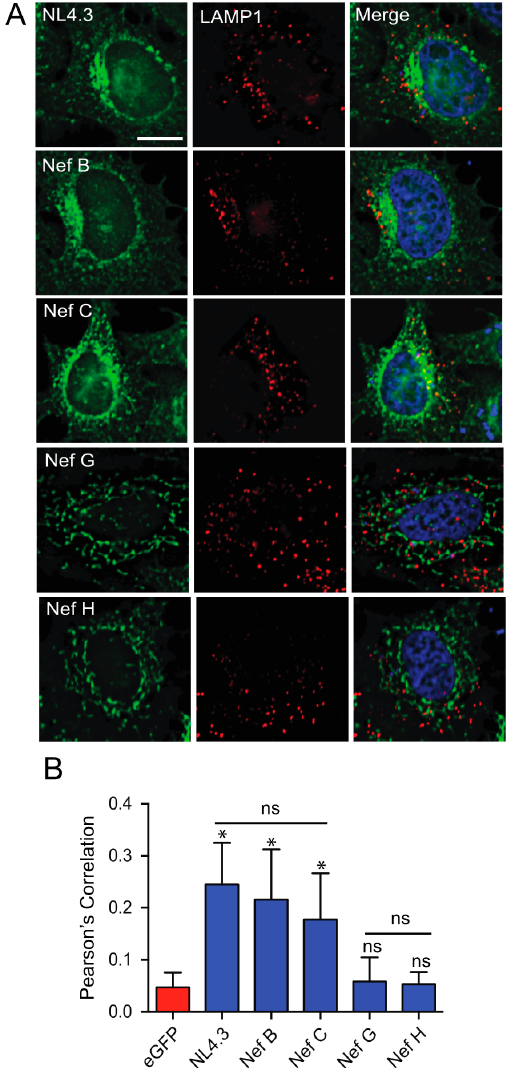
Figure 4. Differing lysosomal colocalization of Nef proteins from reference strains of HIV-1 group-M subtypes. ( A ) CD4 HeLa cells were transfected with various pN1 Nef–eGFP fusion plasmids encoding Nef from different HIV-1 subtypes, and immunostained for lysosome-associated membrane protein 1 (LAMP1). Cells were fixed in 4% paraformaldehyde and imaged on a Leica DMI6000 B widefield microscope on the 100 × objective; scale bar = 10 µ m, green = Nef–eGFP, red = LAMP1. ( B ) Images were deconvolved, and colocalization analysis was completed using the Pearson’s Correlation with the JaCoP Image J plugin. Mean (+/ − SD) Pearson’s correlations of Nef and LAMP1 colocalization are illustrated from three independent experiments. Red bar = negative control. (ns: non-significant; * p ≤ 0.05; SD: standard deviation).